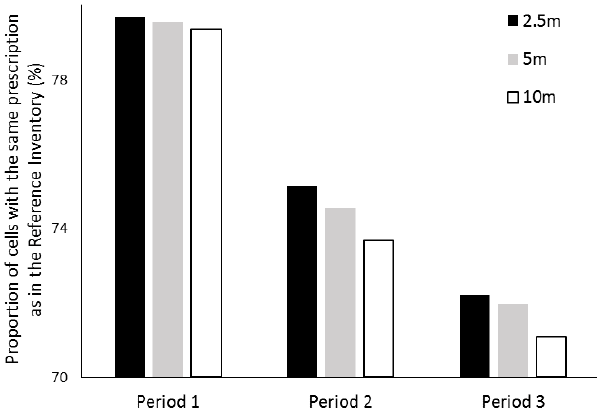
Figure 6. Proportion of cells prescribed in the same way as in the Reference inventory for the three 10-year periods and the three simulated plot positioning errors (2.5, 5 and 10 m). Please note that y axis is cut at 70%.